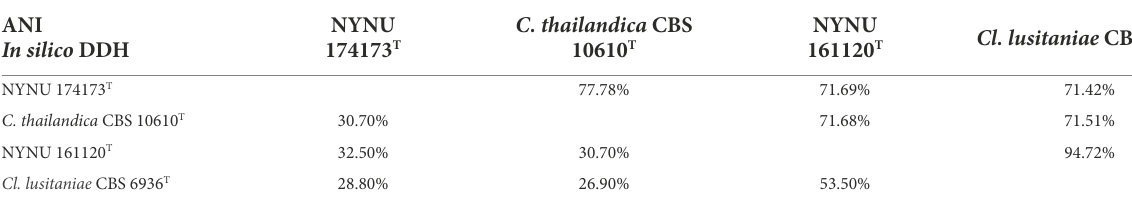
TABLE 5 Matrix of in silico DNA–DNA hybridization (DDH) and Ortho average nucleotide identity (OrthoANI) percentages between the genomes of strains NYNU 174173 T and NYNU 161120 T and the type strains of the most closely related species in the Clavispora clade. ANI In silico DDH